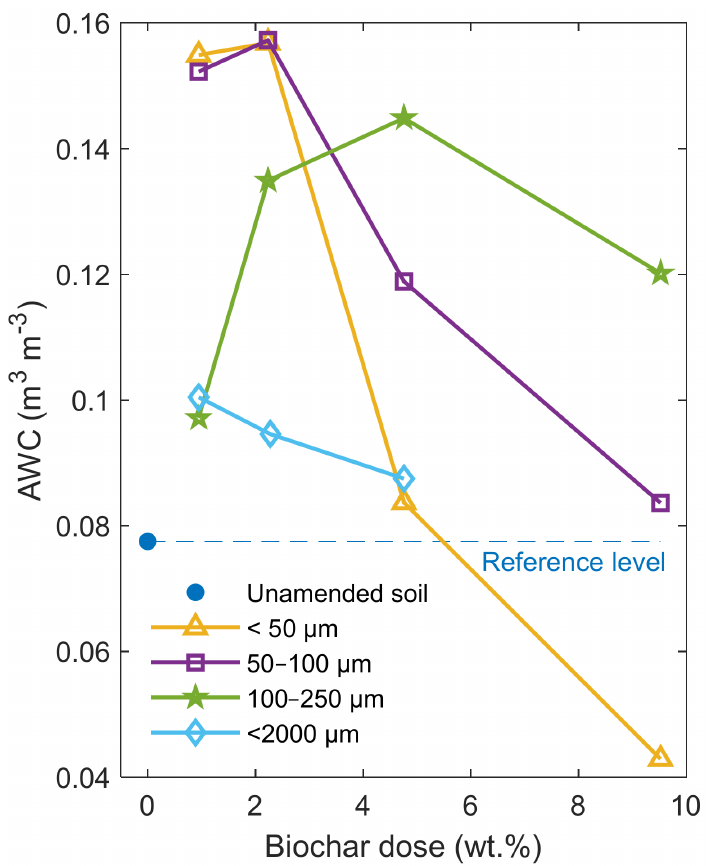
Figure 6. Available water content (AWC) of the investigated soil-biochar mixtures compared to the unamended sandy soil results. The sunflower husk biochar caused an increase in the AWC value at almost all doses and fractions. The most significant changes were observed for the finest size fractions below 100 µ